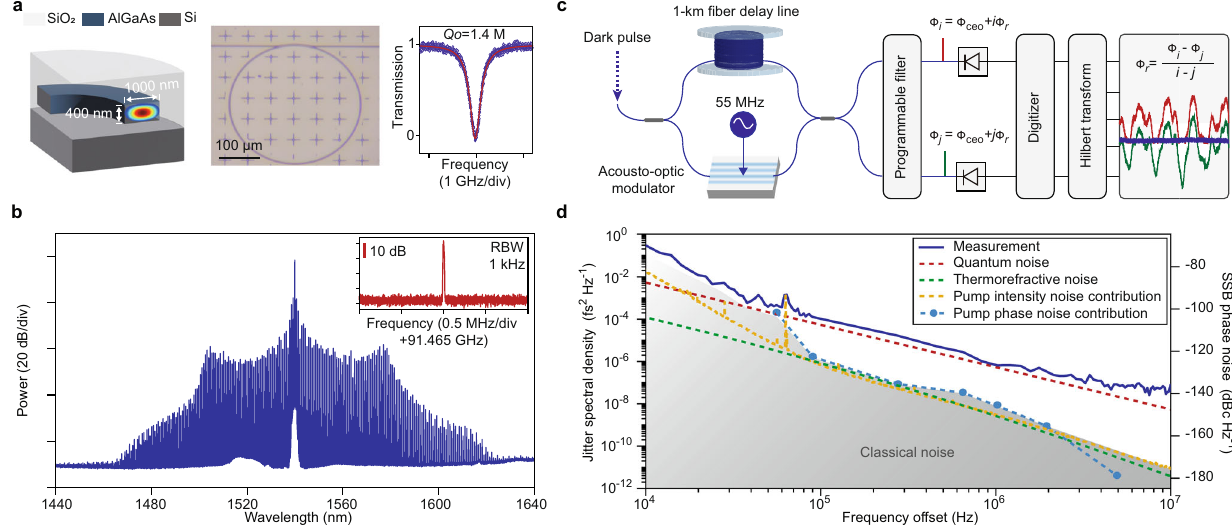
Fig. 2 | Characterization of dark pulses in AlGaAsOI microresonators. a Left panel: the cross-sectional view of the microresonator with core dimensions of 400nm×1000nm. The pro fi le of the fundamental TE mode is overlaid. Middle panel: photograph of the AlGaAsOI microresonator usedin thisstudy. Right panel: transmission spectrum showing the intrinsic quality factor as 1.4 million. b Typical optical spectrum of a dark pulse. Inset: electrical spectrum showing dark pulse repetitionfrequency. c Schematicillustrationofthetimingjittermeasurement.The